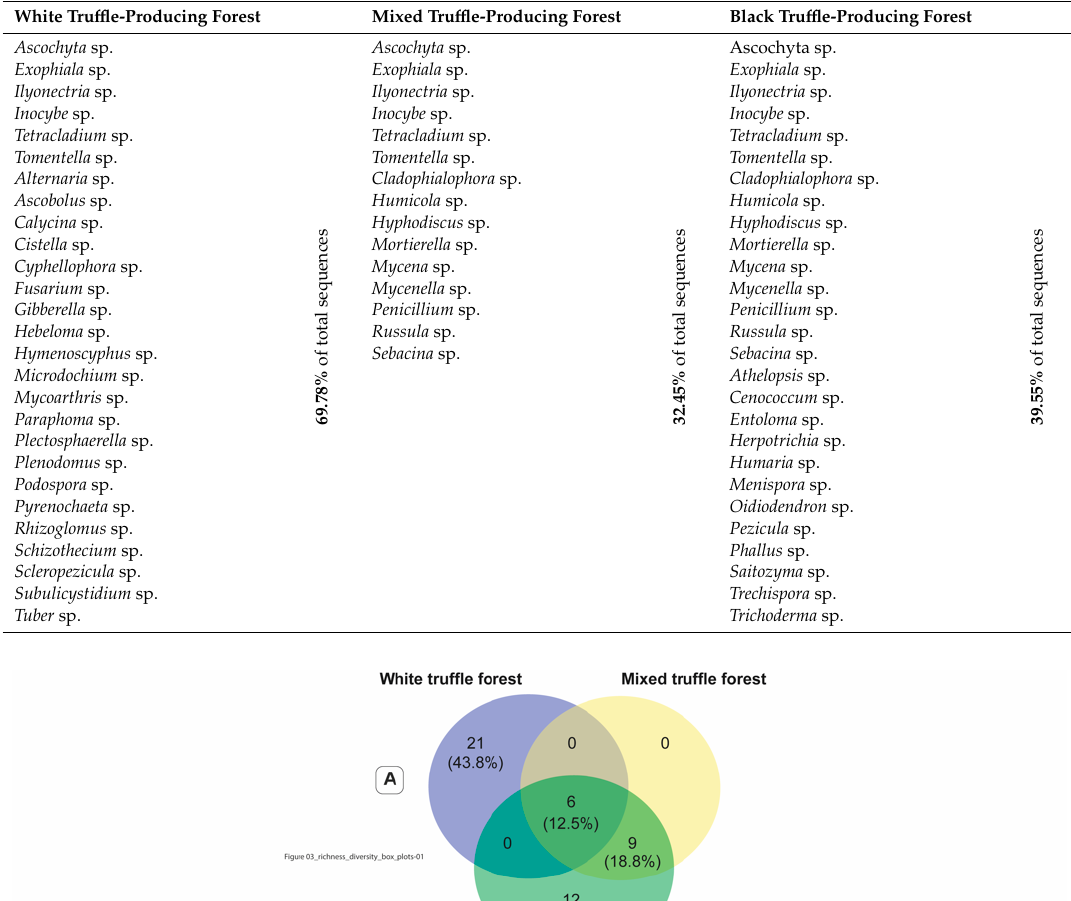
Table 4. Core fungal genera (defined as taxa present in 95% samples of the specific forest type) associated with white, black, and mixed tru ffl e-producing forests and their collective percent share of the sequences from the total sequences belonging to a specific group. White Tru ffl e-Producing Forest Mixed Tru ffl e-Producing Forest Black Tru ffl e-Producing Forest Ascochyta sp.